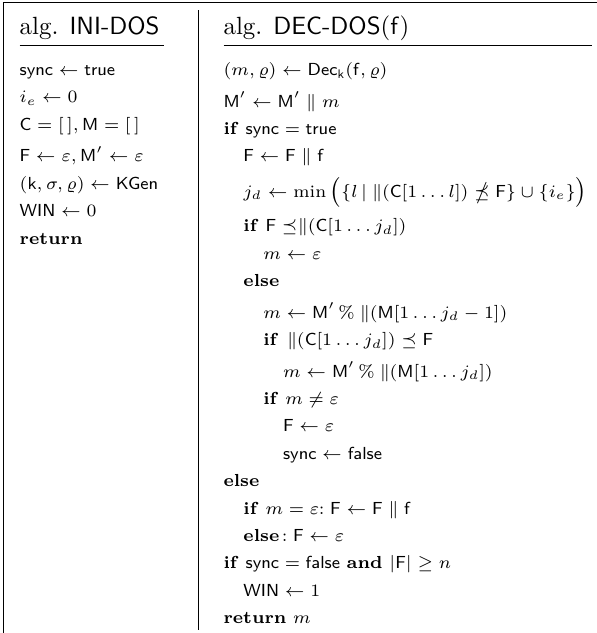
Figure 7: Algorithms for defining DOS - sfCFA